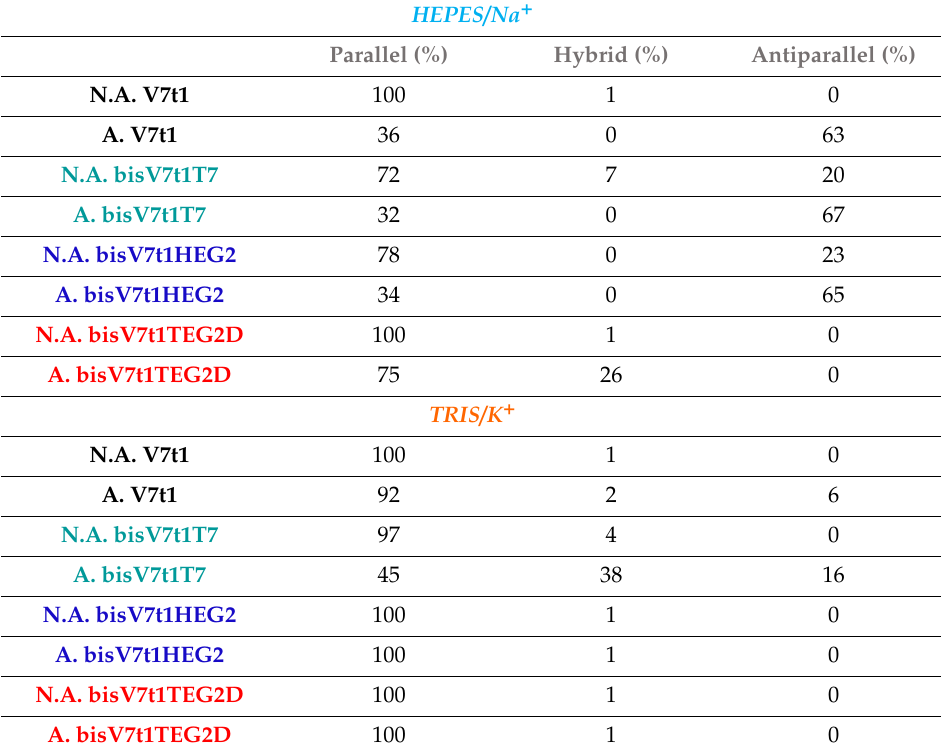
Table 2. Prediction of relative abundance of the G4 topologies adopted by N.A. and A. samples. Prediction of G4 Topologies Relative Abundance from SVD Analysis of CD Spectra HEPES / Na + Parallel (%) Hybrid (%) Antiparallel